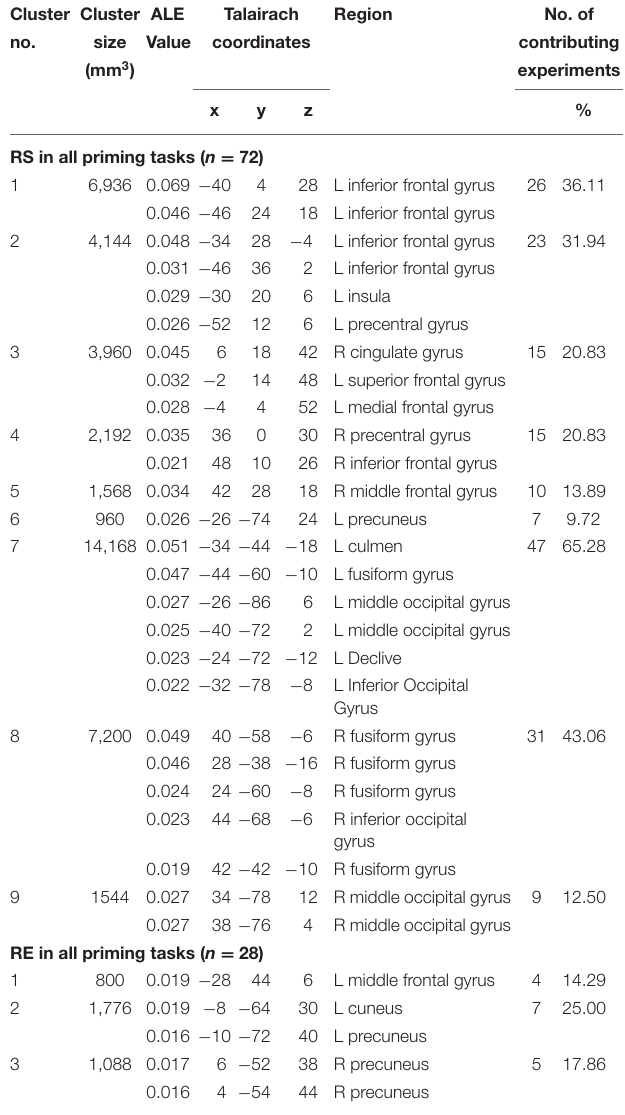
TABLE 2 | Brain regions showing RS or RE across all priming contrasts. Cluster Cluster